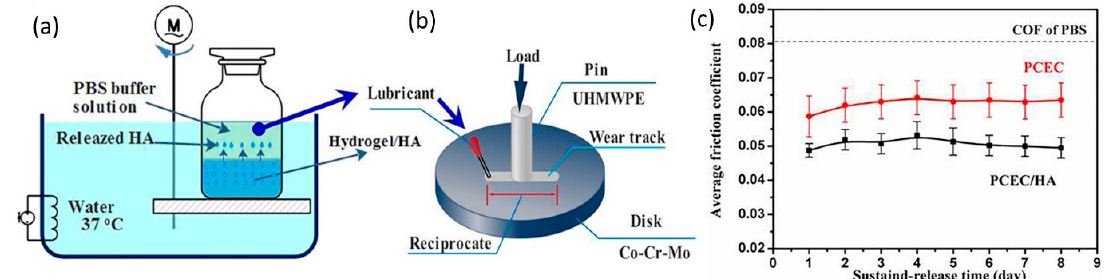
Figure 4 . ( a ) HA release test from the hydrogel and ( b ) removing the liquid to measure its properties as a lubricant using a tribometer ( c ) Average friction coefficients of the sustained-release HA solutions for 8 days. COF—Coefficient of friction, UHMWPE—Ultrahigh molecular weight polyethylene.